Question: In one sentence, what is this figure communicating?
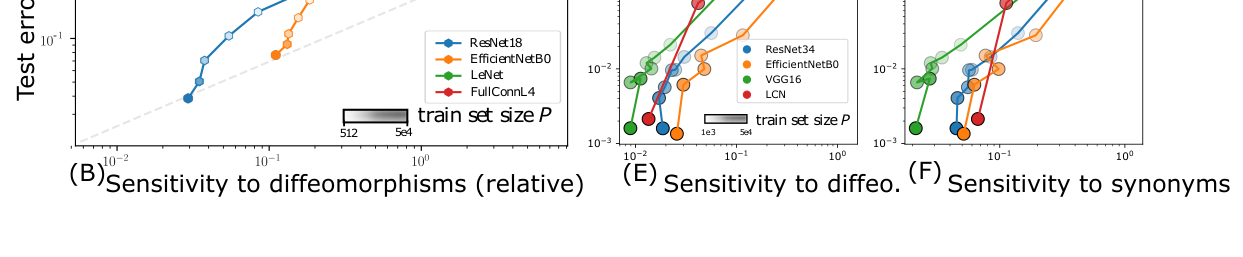
Answer: CIFAR 10: (A) Test error vs sensitivity to diffeomorphisms of common architectures trained on all CIFAR10, showing a remarkable correlation between the two quantities. A grey line, corresponding to a power-law, guides the eye. (B) Same as (A), for increasing size of the training set P, whose value is indicated by the degree of opacity. The sensitivity to smooth transformations is computed in relative terms to the sensitivity to white noise. (A, B) are adapted from (Petrini et al., 2021). The SRHM captures these observations: (C) Test error vs sensitivity to diffeomorphisms of a CNN trained with P = 7400 on the SHRM model, with parameters L = s = s0 = 2 and nc = m = 10. The sensitivity to diffeomorphisms is defined as the change of network output induced by a diffeomorphism applied on the input, see Eq. 7. For details about the architectures and their training process, see Appendix B. (D) Same as (C) for sensitivity to exchange of synonyms, defined as the change of the network